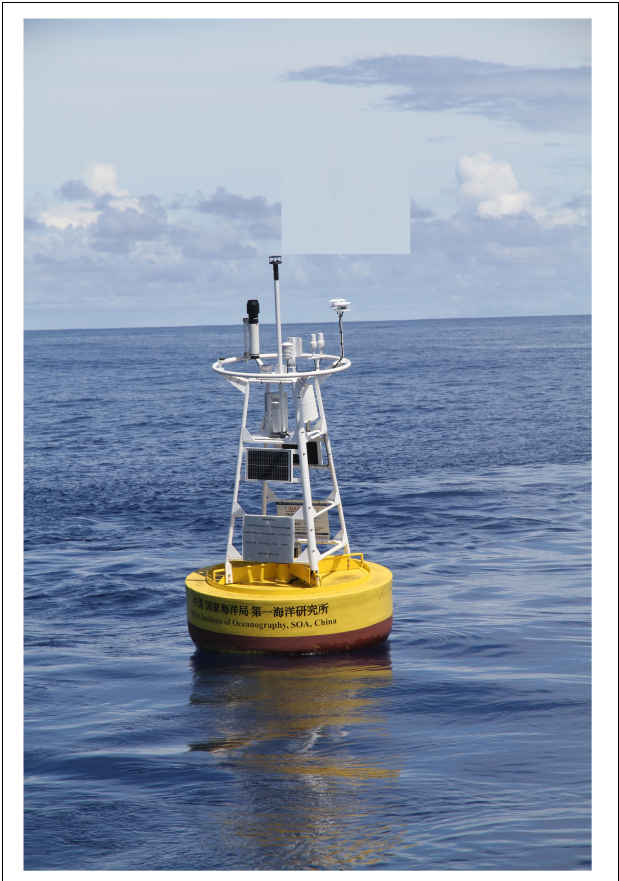
FIGURE 1 | Deployed system, RAMA – Indian